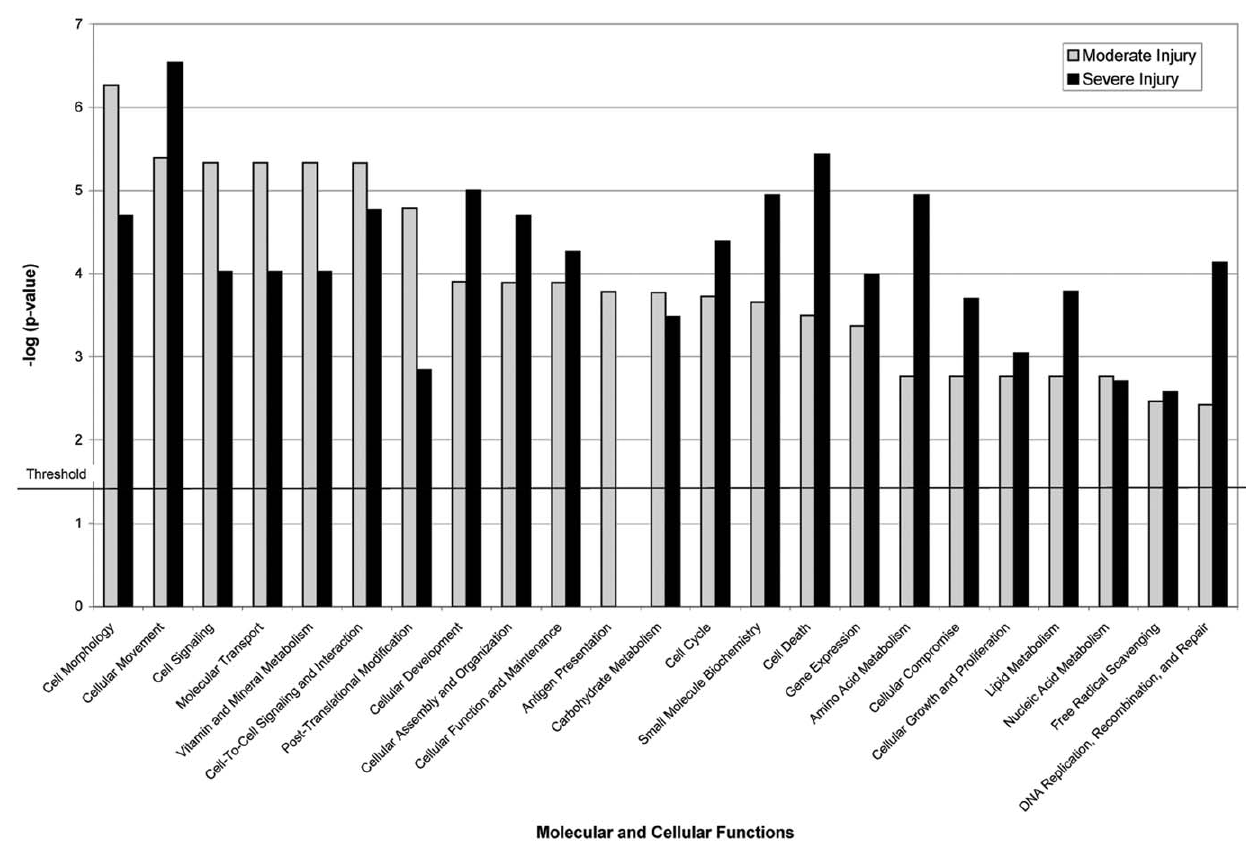
Figure 5. Results of LC-MS/MS data analysis using core module of the Ingenuity Pathways Analysis (IPA) software package. The LC- MS/MS data set was filtered for proteins present in CSF only. The proteins from this filtered dataset that met the 1.5 fold cut-off criteria and were associated with biological functions in the IPA Knowledge Base were considered for the analysis. A p-value determining the probability that each biological function assigned to that data set is due to random chance alone was calculated using right-tailed Fischer’s exact test. P-values , 0.05 were considered statistically significant.